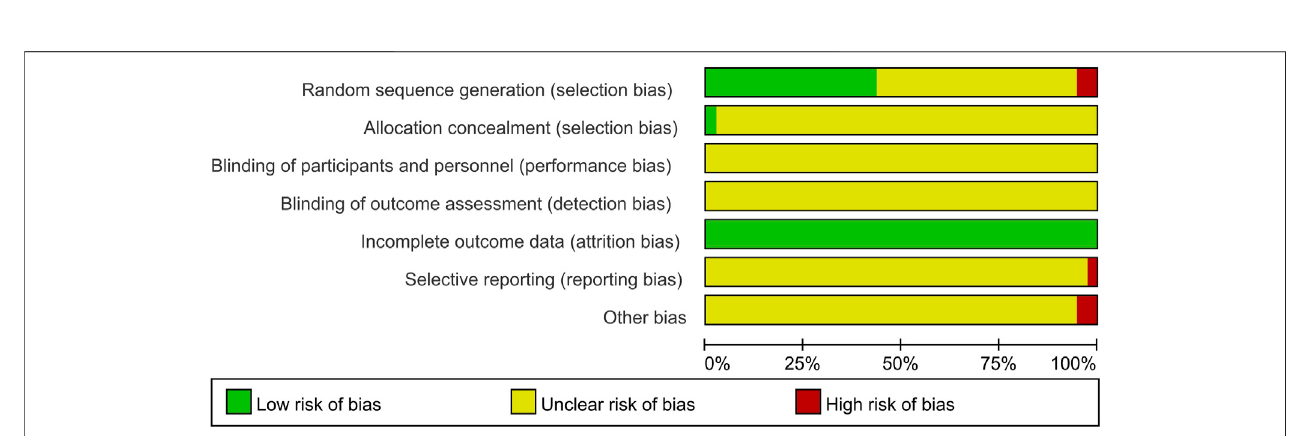
FIGURE 2 | Network graph for different outcomes. (A) Clinical effective rate, (B) performance status, (C) leukopenia, (D) thrombopenia, (E) nausea and vomiting, and (F) grade ≥ 3 oral mucositis. Note: (CCRT, concurrent chemoradiotherapy; AD, Aidi injection; CKS, Compound Kushen injection; EL, Elemene injection; KA, Kangai injection; KLT, Kanglaite injection; SM1, Shengmai injection; SQFZ, Shenqqifuzheng injection; SM2, Shenmai injection; and XAP, Xiaoaiping injection).